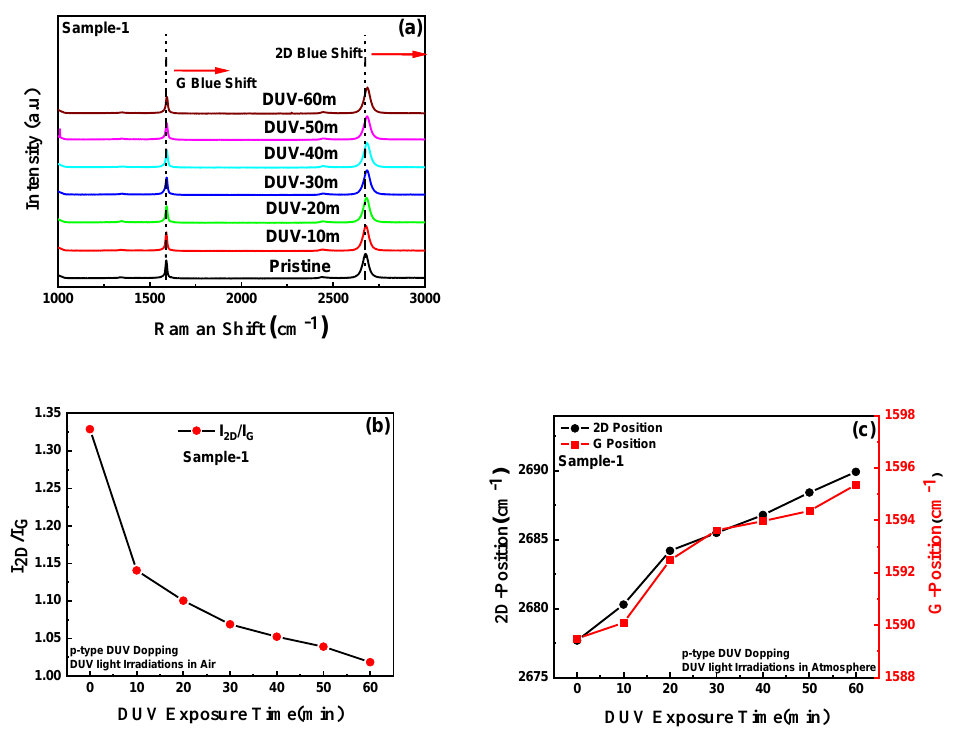
Figure 2. Raman spectroscopy analysis: ( a ) Raman spectra of pristine graphene and p-type doped sample-1 by DUV irradiation in air with different exposure times, showing the blue shift in 2D and G peaks towards higher wavenumbers. ( b ) A shift in the 2D and G peak intensity ratios with an increment in DUV exposure time. ( c ) The 2D and G peak positions as a function of DUV exposure time, showing the shift towards higher wavenumbers with an increase in the p-type doping effect by DUV irradiation in air.